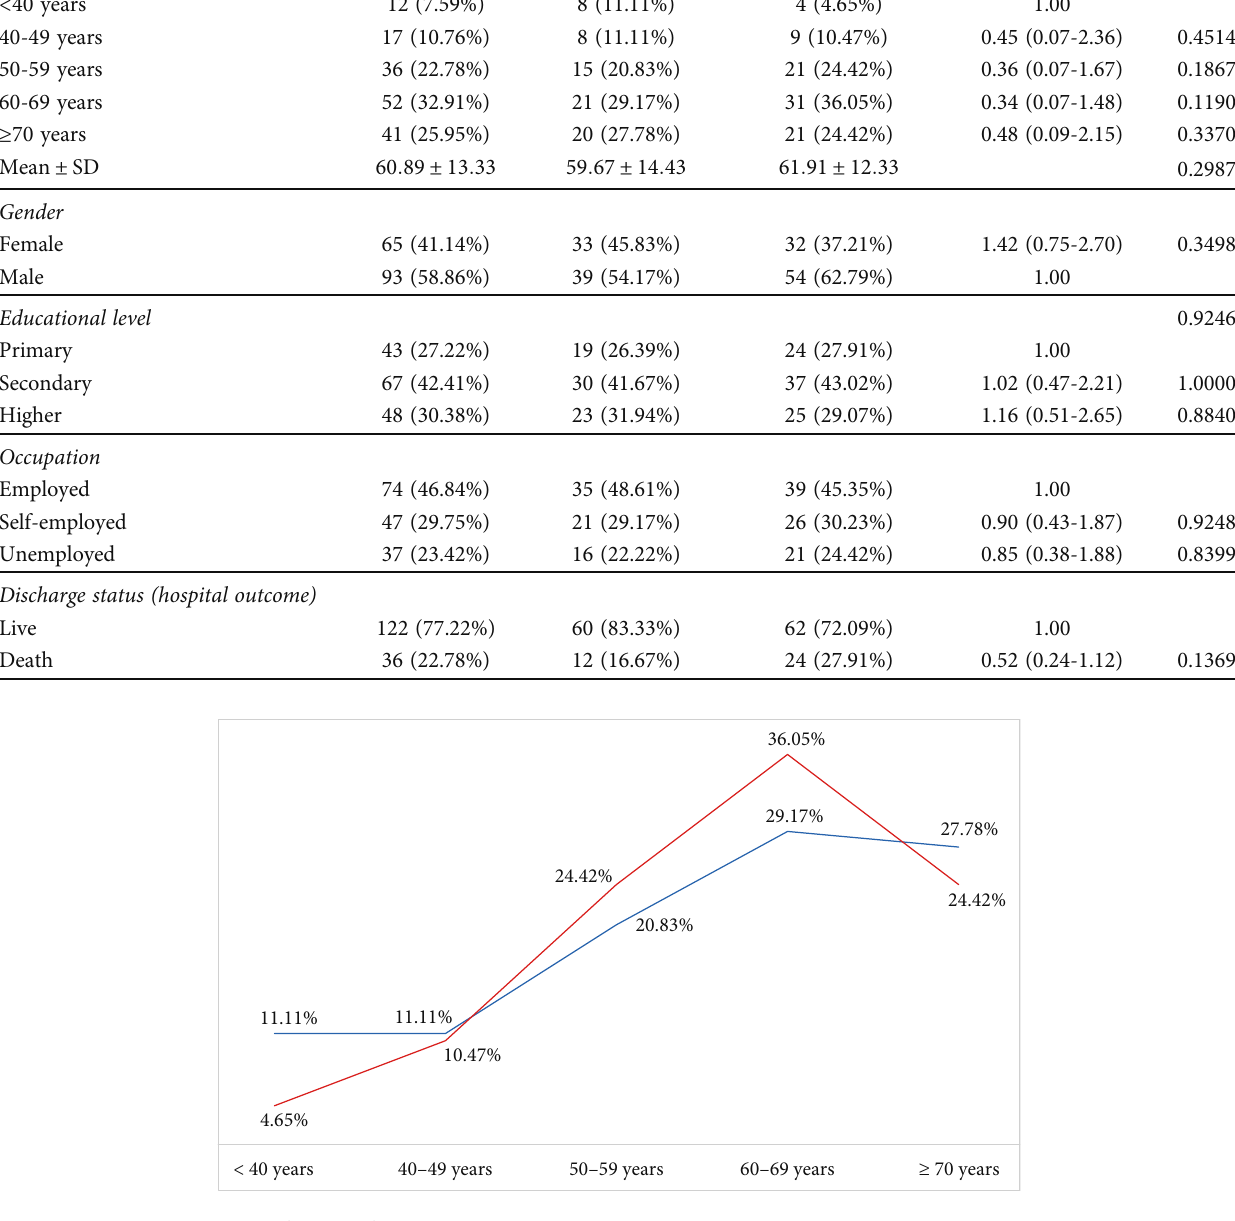
Figure 1: Prevalence of stroke subtypes by age